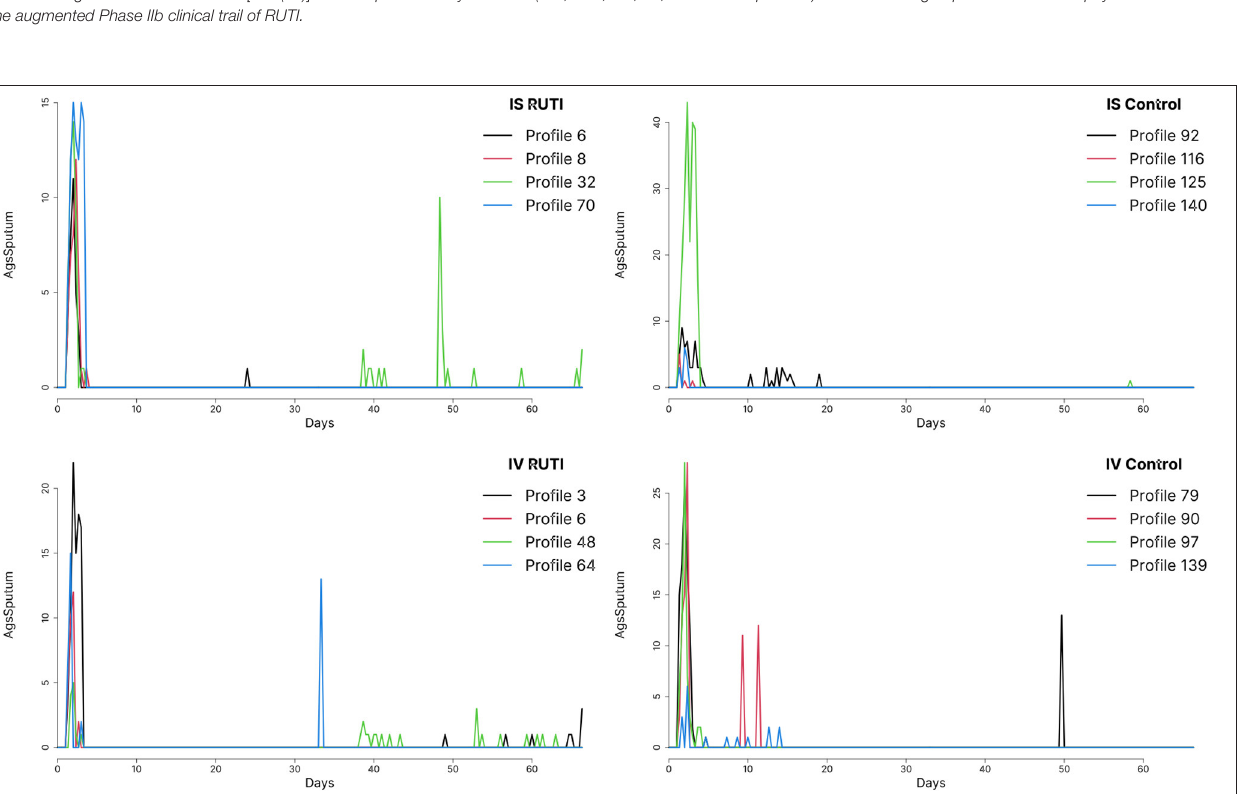
from the in silico experiment onto the augmented trial. We implement these Bayesian models using a benchmark prior, but our methodology can accommodate